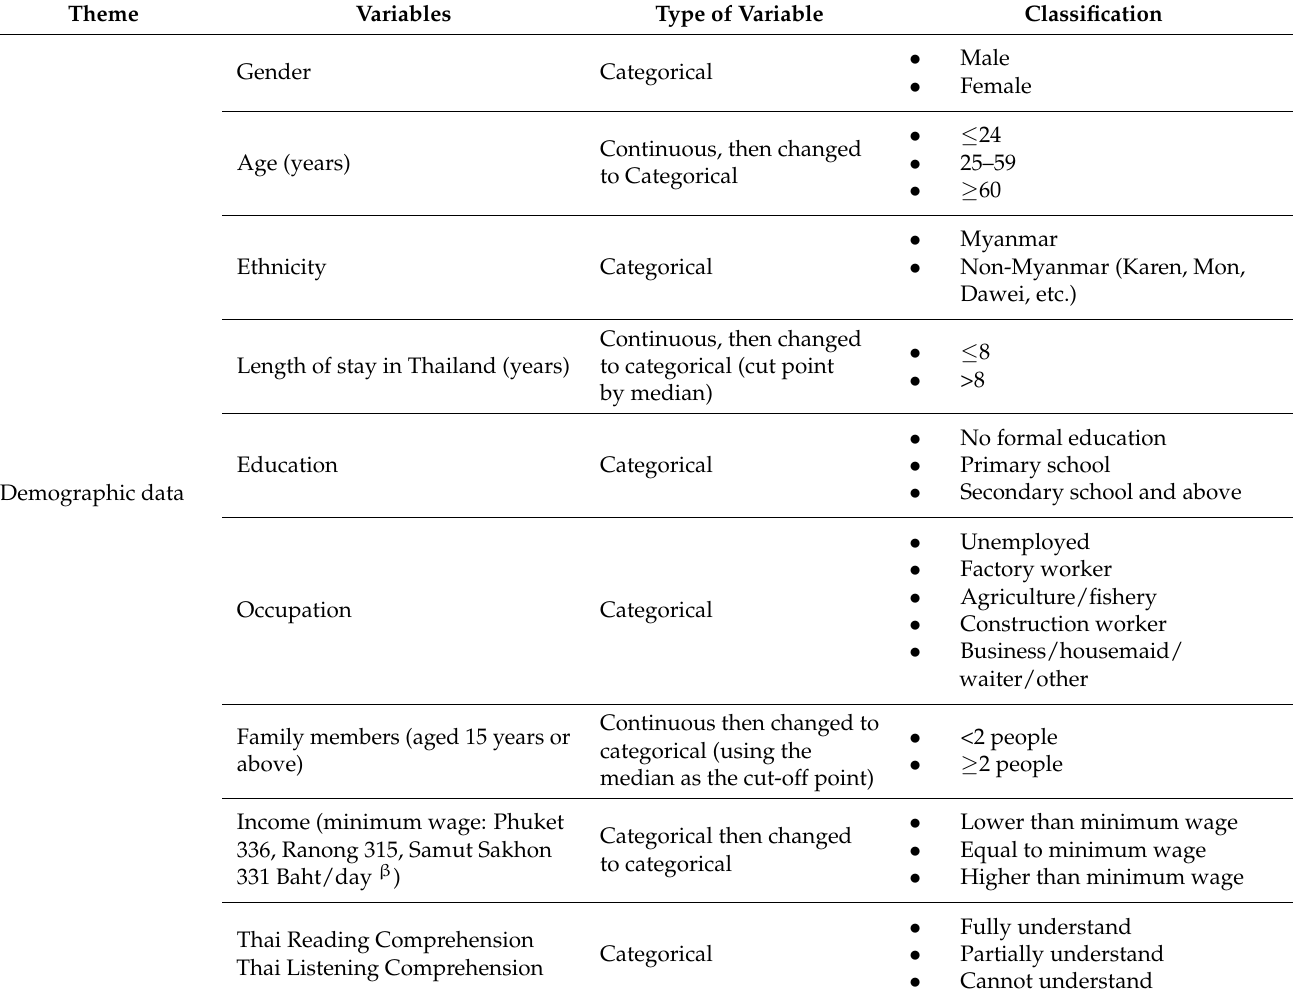
Table 2. Characteristics of the variables and variable